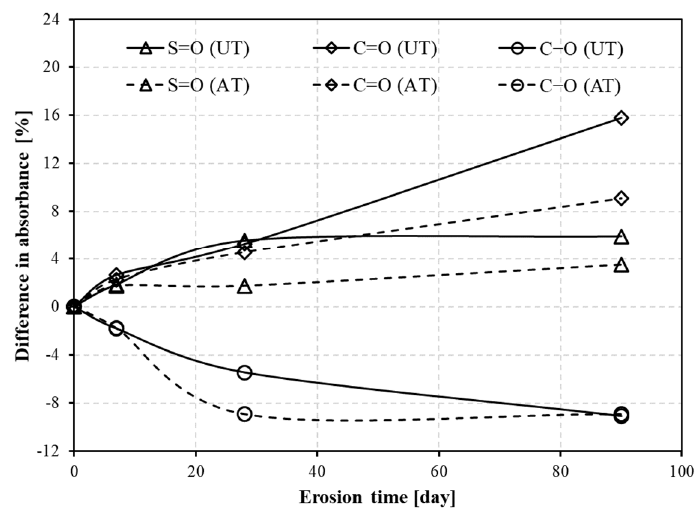
Figure 4. Difference in absorbance of neat bitumen and aged bitumen under acid rain